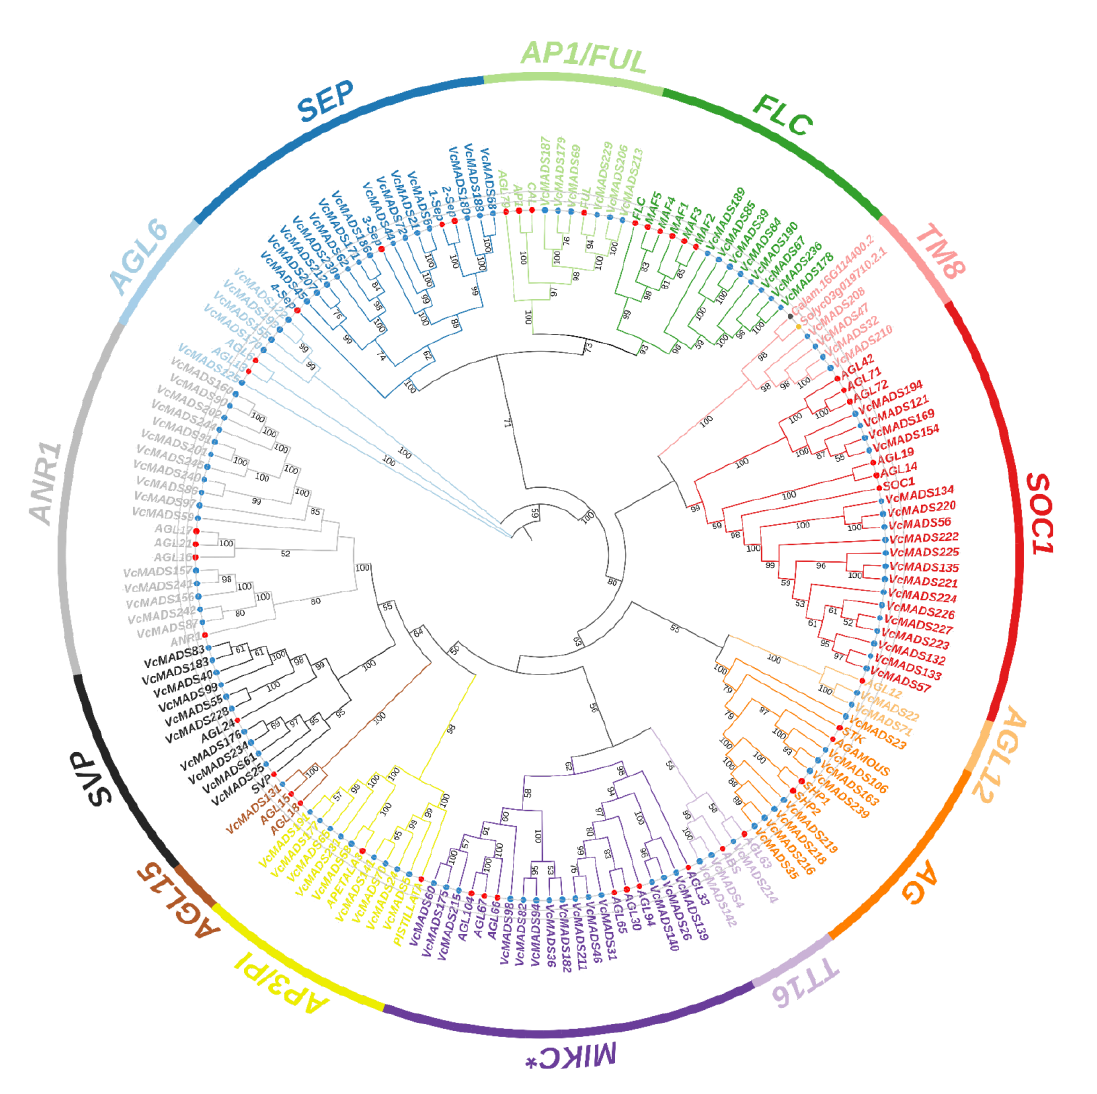
Figure 2. Phylogenetic tree of type II (MIKC-type) MADS-box proteins from blueberry, Arabidopsis, Calam.16G114400.2, and Solyc03g019710.2.1. MADS-box proteins of blueberry, Arabidopsis, Calam.16G114400.2, and Solyc03g019710.2.1 are marked by blue, red, brown, and orange circles, respectively. The digits on the branches represent bootstrap values for 1000 replicates.